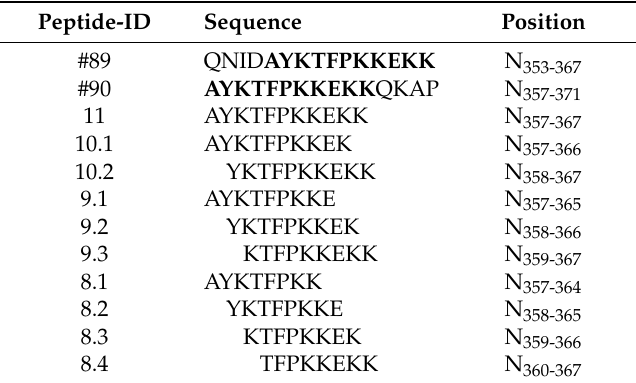
Table 1. Peptide information.